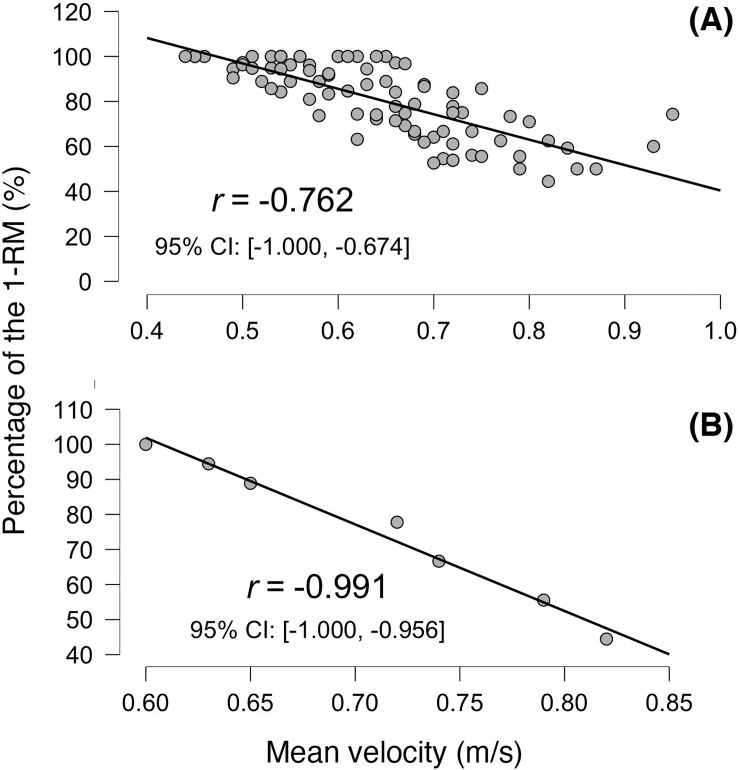
Generalized (A) and a typical load-velocity relationship in the bilateral leg extension exercise (B).